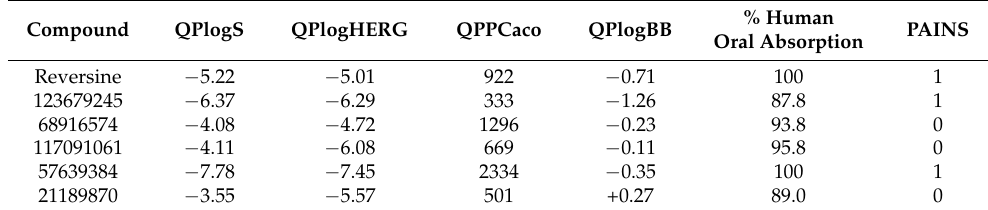
Table 3. Some of the key physicochemical descriptors of selected compounds that were computed with QikProp and structural alerts